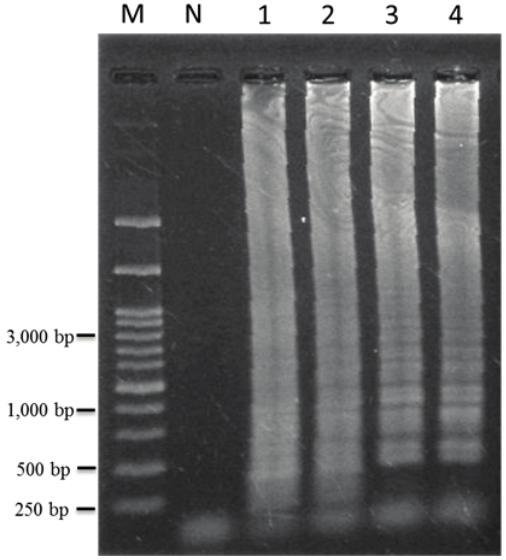
Figure 5. Identification of Taraxacum formosanum contaminated with various ratios of adulterant’s genomic DNA using the LAMP method. The genomic DNA of T. formosanum and non-target DNA (genomic DNA of Ixeris chinensis ) were mixed in the ratio 1:10 (lane 4), 1:50 (lane 3) and 1:100 (lane 2), respectively. Lane M, DNA marker; lane N, negative control (genomic DNA of Ixeris chinensis ); lane 1, 130 ng genomic DNA of each species, Taraxacum officinale , Ixeridium laevigatum , Youngia japonica , Ixeris chinensis and Emilia sonchifolia var. javanica , were all mixed with 130 ng genomic DNA of T. formosanum into one